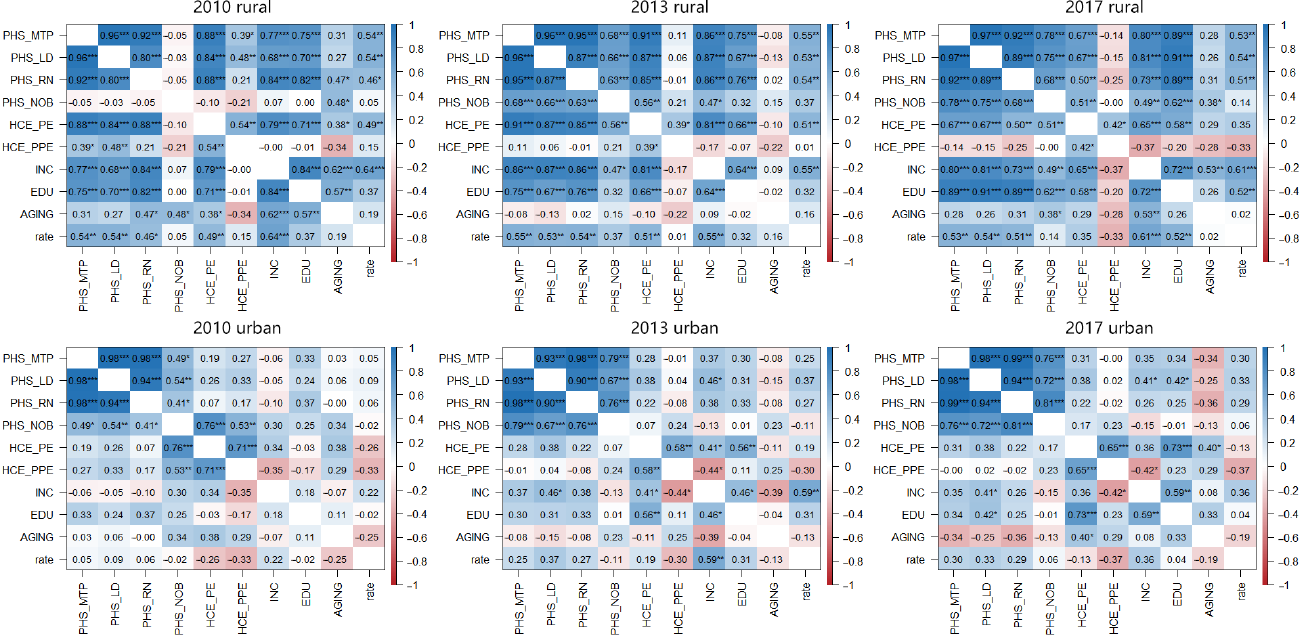
Figure 3. The correlation matrix among SRHS and different influence factors at the provincial level. * p < 0.05, ** p < 0.01, *** p < 0.001.